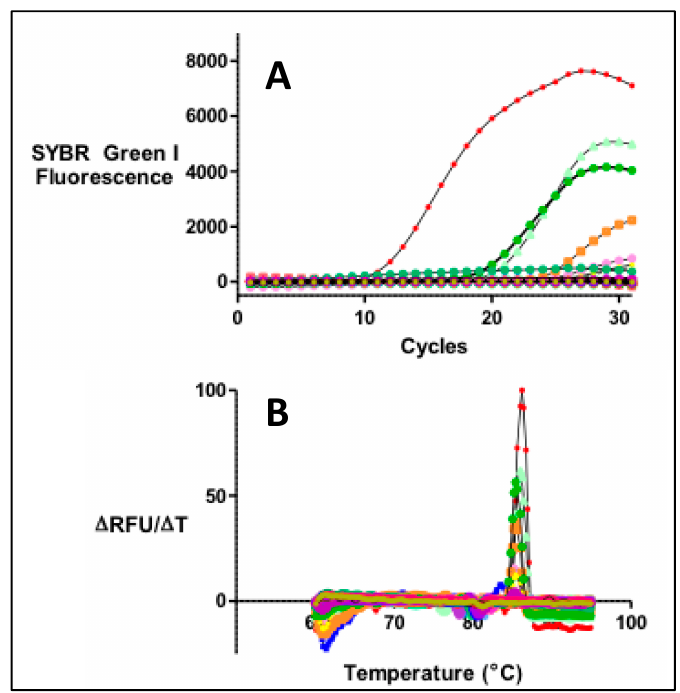
Figure A1. ( A ) Real-time PCR reactions were performed for the quantitation of DNA in stool samples compared with a set of standards of known concentration for each of the genes, ( B ) The presence of a single PCR product was ascertained by monitoring a DNA melting profile immediately after the PCR reaction. The presence of a single peak for each sample is indicative of a single PCR product.